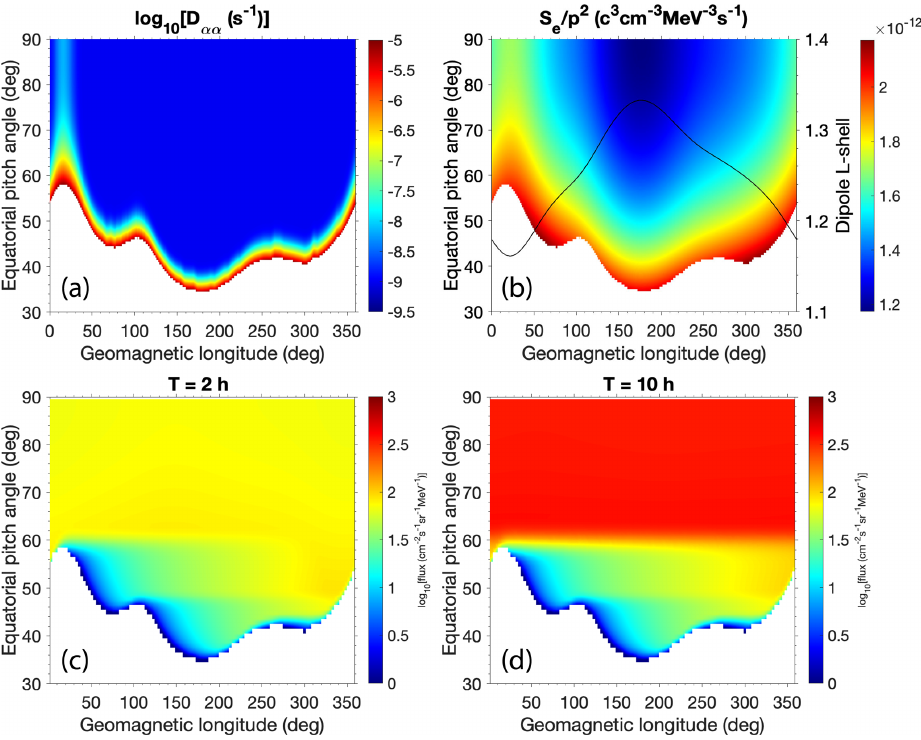
Figure 5. (a) Bounce-averaged pitch-angle diffusion coefficient D αα (s − 1 ) for 304keV electrons. The blank area is in the bounce loss cone. (b) CRAND electron source rate S e /p 2 ( c 3 cm − 3 MeV − 3 s − 1 ) for 304keV electrons. The black line plots the variation of dipole L-shell versus geomagnetic longitude against the right y axis, corresponding to the McIlwain’s L M = 1 . 25. (c) Calculated electron fluxes (cm − 2 s − 1 sr − 1 MeV − 1 ) at T = 2h. (d) Calculated electron fluxes (cm − 2 s − 1 sr − 1 MeV − 1 ) at T = 10h.